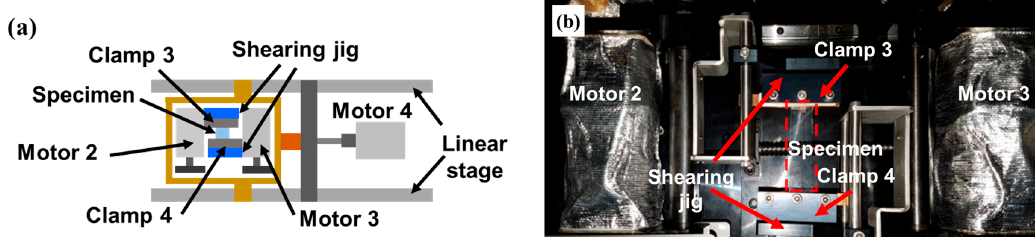
Figure 3. Configuration for shearing test ( a ) schematic; ( b ) actual photograph.